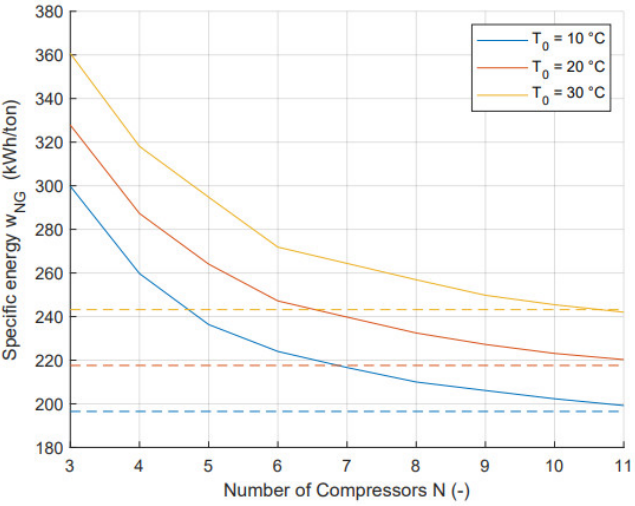
Reproduced with permission from MDPI. Figure 9. Variation of the specific energy consumption of optimized process with N compressor stages and ambient seawater temperature T 0 . Dashed lines are mixed fluid cascade (MFC) processes [47].